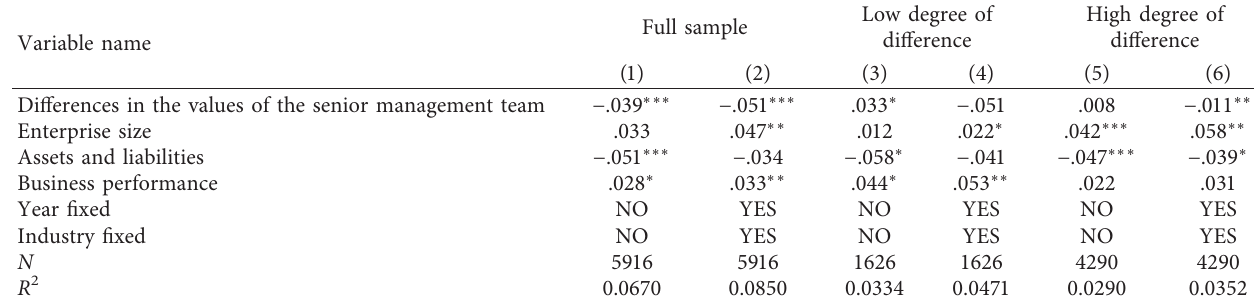
Table 5: Regression analysis results of differences in the values of the senior management team and the ability to resist